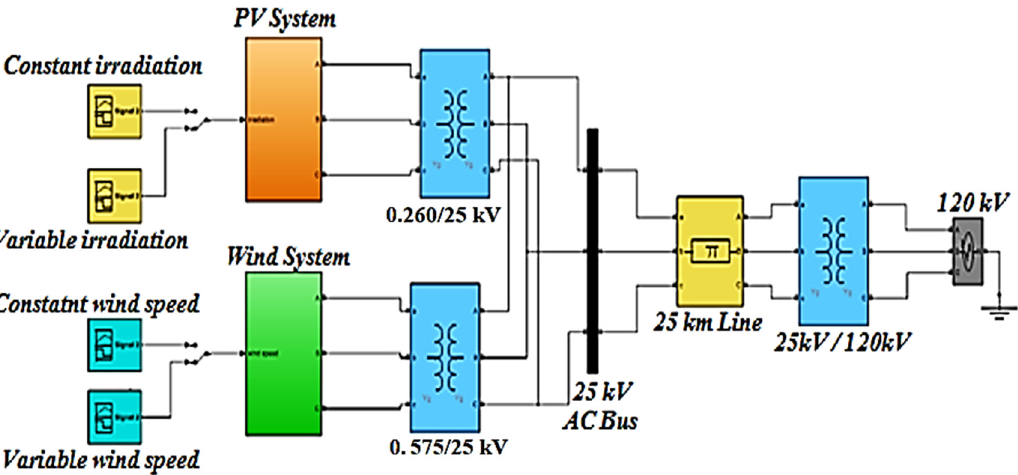
Figure 13. Overall simulated model of grid-connected PV/wind system.